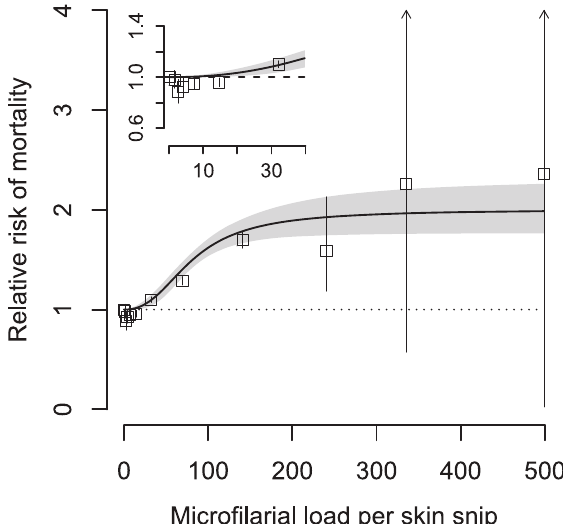
Figure 1. Relative mortality risk with increasing Onchocerca volvulus microfilarial load in the Onchocerciasis Control Programme cohort. Observed (open squares) and fitted (solid line) relative risk of mortality, with fitted (log-)sigmoid dose-response model adjusted to the average age of individuals within the cohort. Shaded (grey) area represents the 95% Bayesian credible interval around the fitted line; vertical error bars are 95% confidence intervals around observations. Inset permits visual inspection of the mortality relative risk at parasite loads # 40 microfilariae per skin snip.